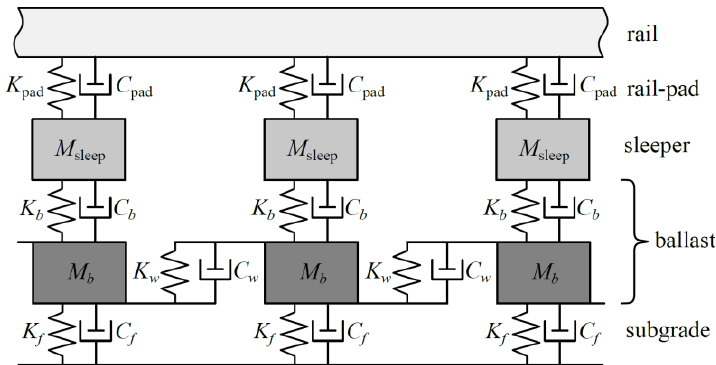
Figure 1. DSM, based on